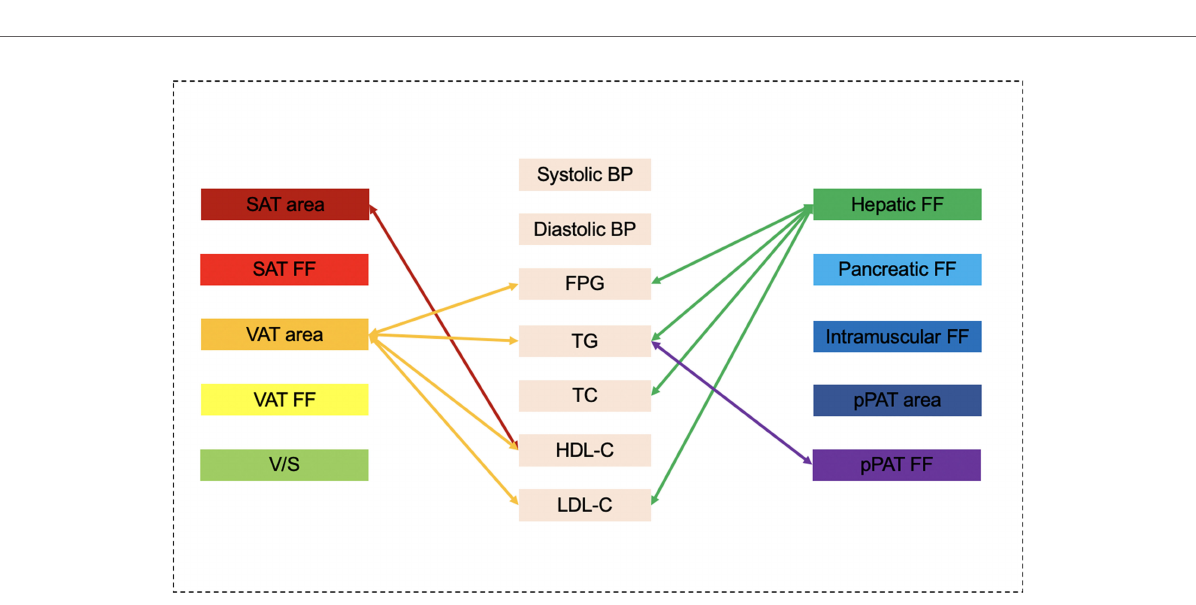
FIGURE 3 | Graphical summary of the important correlates between various MRI-acquired fat measurements and continuous cardiometabolic risk factors independent of BMI shown in the present study. VAT area and hepatic fat were signi fi cantly associated with multiple continuous cardiometabolic risk